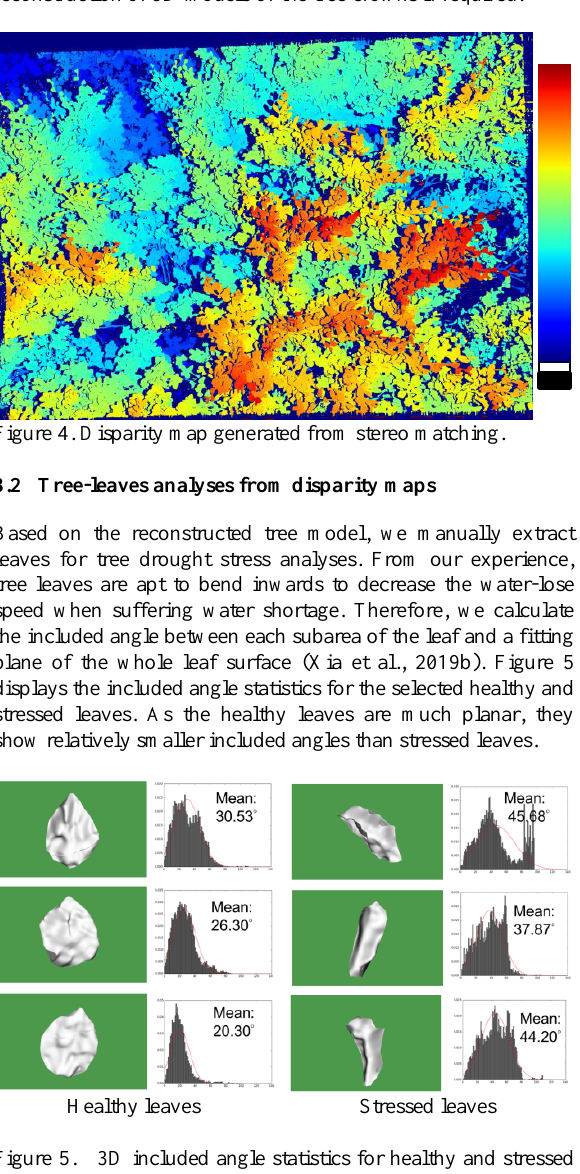
Figure 5. 3D included angle statistics for healthy and stressed